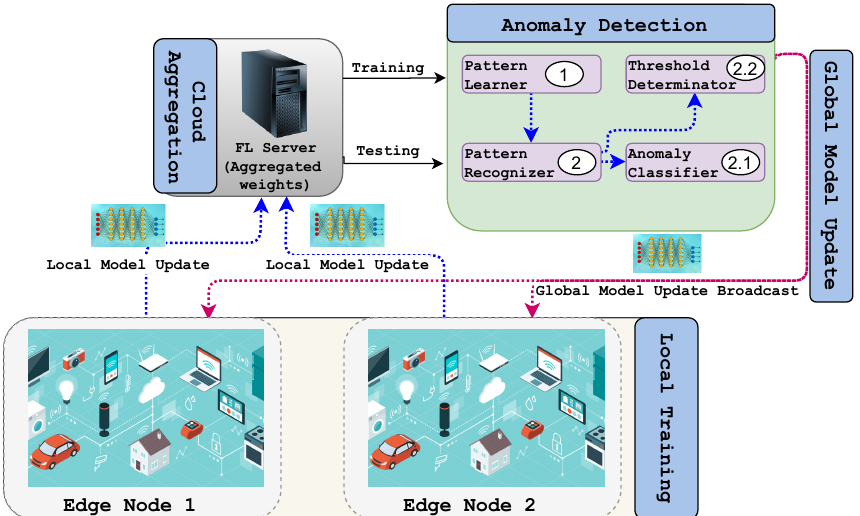
Figure 10. Federated learning-based anomaly/attack detection framework for edge